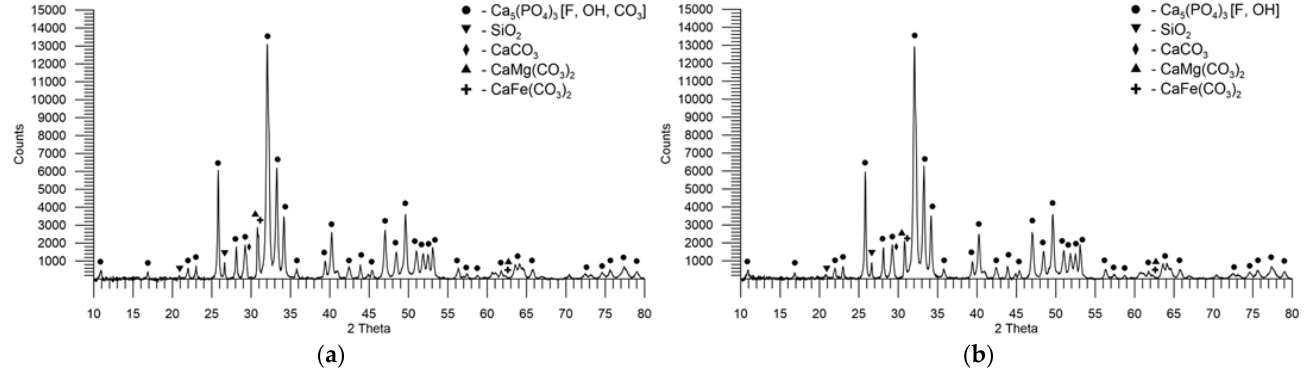
Figure 4. XRD pattern of PRs from various deposits: ( a ) PR1; ( b ) PR4.